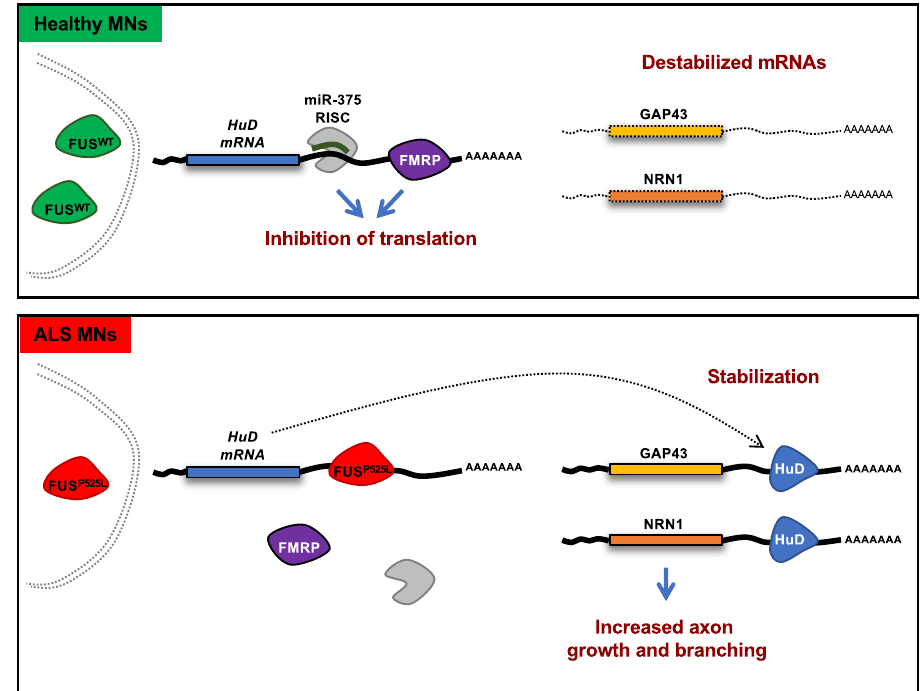
Fig. 9 Model depicting the proposed molecular mechanism underlying HuD regulation by FMRP and mutant FUS. The fi gure depicts a model of the competition between mutant FUS and FMRP for HuD 3 ′ UTR binding. In FUS WT MNs, the FUS protein is predominantly localized in the nucleus. In the cytoplasm, FMRP binds HuD 3 ′ UTR repressing its translation. NRN1 mRNAs are destabilized. In FUS P525L MNs, mutant FUS is partially delocalized to the cytoplasm and outcompetes FMRP binding on the HuD 3 ′ UTR. As a consequence, increased HuD protein levels accumulate in FUS mutant MNs. HuD binding to NRN1 and GAP43 3 ′ UTR leads to stabilization of these transcripts and higher protein levels. NRN1 increase underlies the aberrant axonal growth